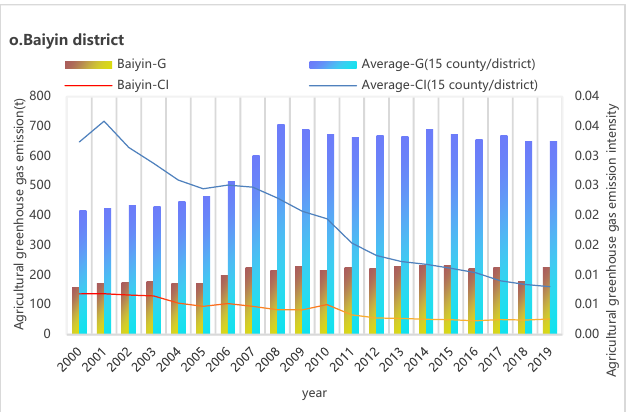
Figure 5. Variations in ( a ) Maqu county, ( b )Linxia county, ( c ) Yongjing county, ( d ) Jishishan county, ( e ) Dongxiang county, ( f ) Gaolan county, ( g ) Yuzhong county, ( h ) Chengguan district, ( i ) Qilihe district, ( j ) Anning districty, ( k ) Xigu district, ( l ) Jingtai district, ( m ) Pingchuan district, ( n ) Jingyuan county, ( o ) Baiyin district, include: the total GHG emissions (county/district-G) and the intensity of agricultural GHG (county/district-CI) in the main stream of Gansu section of the Yellow River Basin from 2000 to 2019.The average is the county (district) average of total agricultural GHG (Average-G) and GHG emissions intensity(Average-CI), in The Main Stream of the Yellow River Basin in Gansu section from 2000 to 2019.